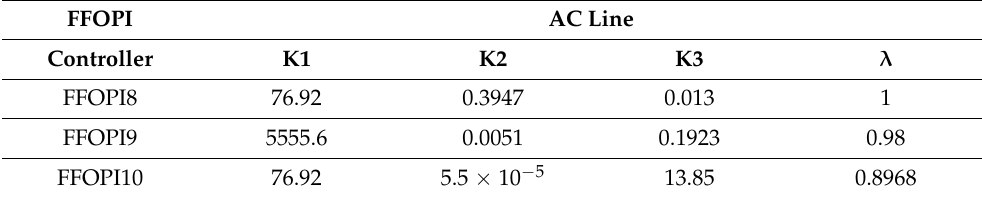
Table 9. FFOPI controller gains of AC line in the case of